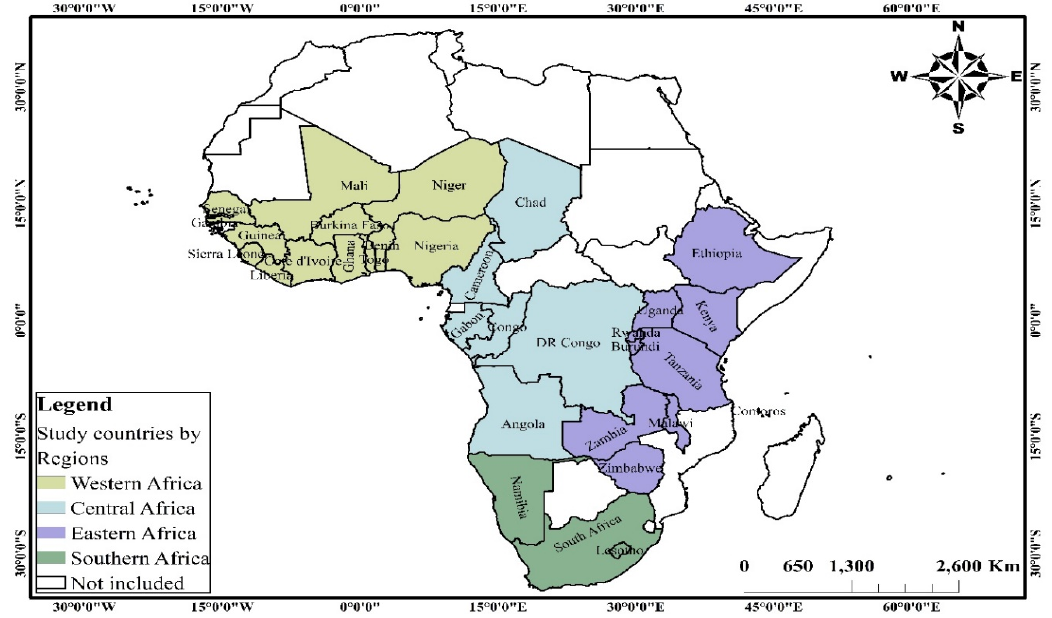
Figure 2. Spatial distribution of study countries by regions of Sub-Saharan Africa. Source: constructed based on shapefiles from https://tapiquen-sig.jimdofree.com/descargas-gratuitas/mundo/ (December 1, 2020) with permission from Carlos Efrain Porto Tapiquen, 2021.